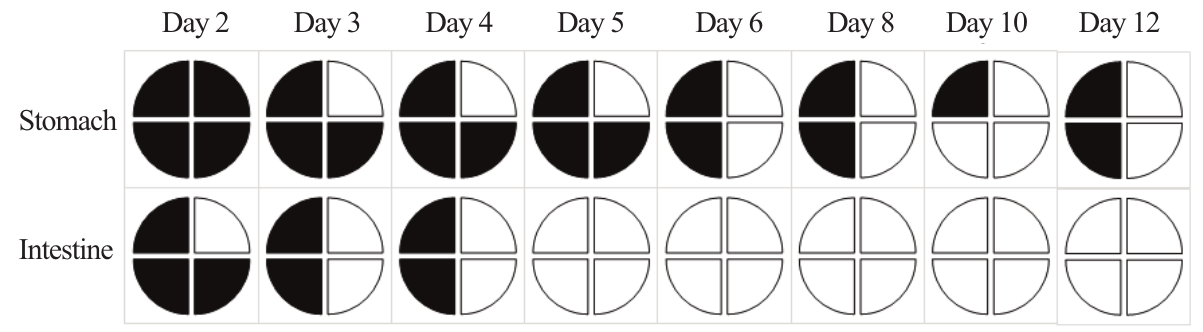
Fig. 2. Content of fibres in stomachs and intestines of crabs 2 to 12 days since the last feeding with fish contaminated by fibres. Each circle represents four replicates; each quarter represents one specimen. Black quarters designate the presence of fibres, white quarter the lack of